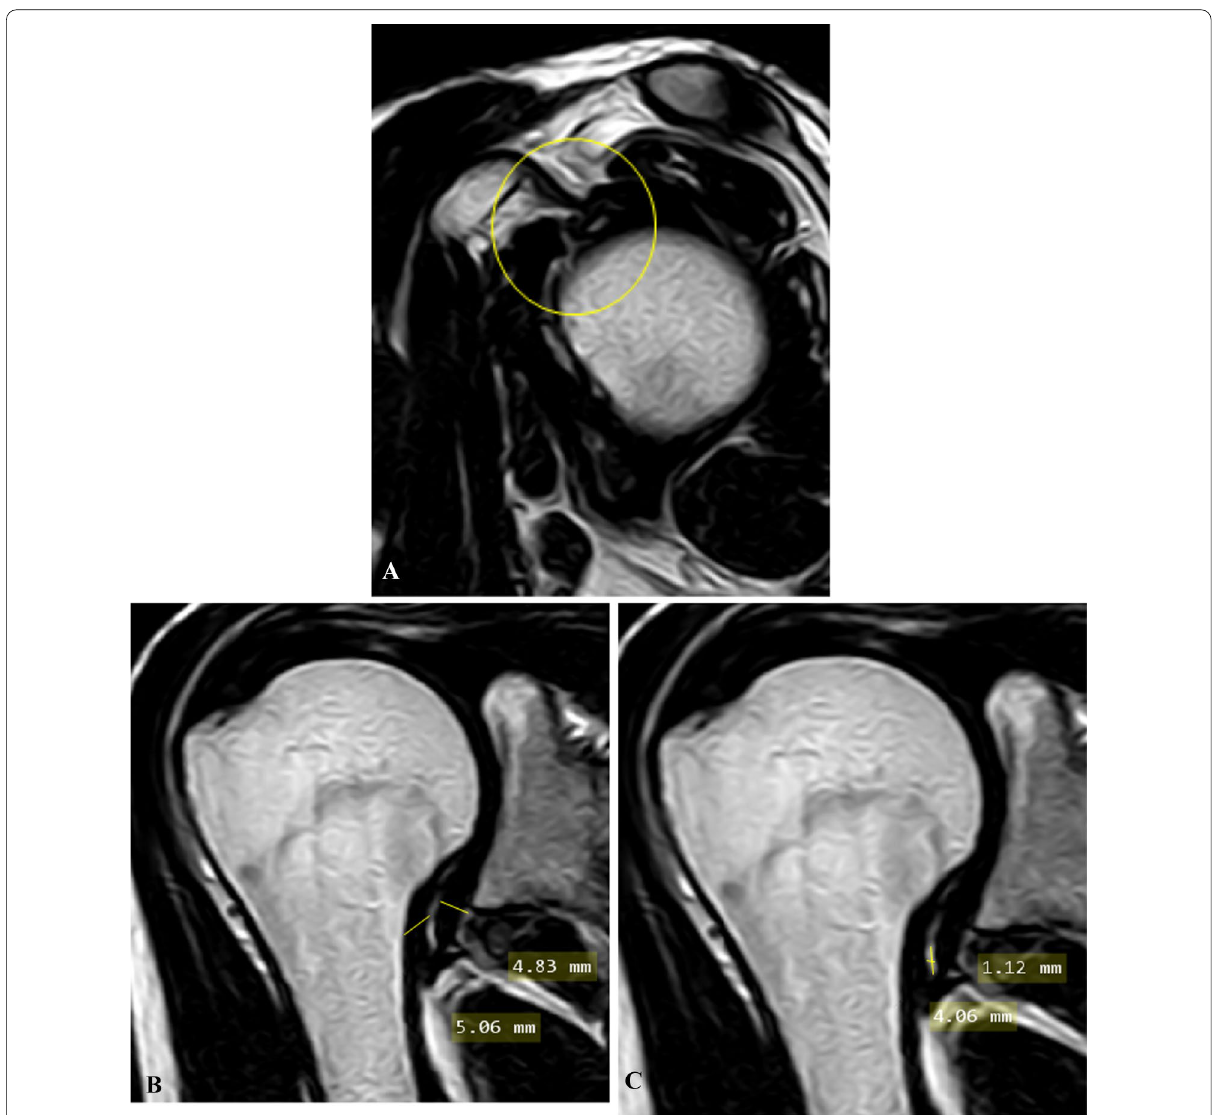
Fig. 4 A Oblique sagittal T2-weihted MR image shows preserved fat planes and coracohumeral ligament of the rotator interval (encircled area). B Oblique coronal T2-weighted MR image shows thickened joint capsule and measurement of maximum capsular thickness of glenoid and humeral portions of axillary recess. C Oblique coronal T2-weighted MR image shows measurement of maximum height and width of axillary recess at the same plan, it was fibrotic and